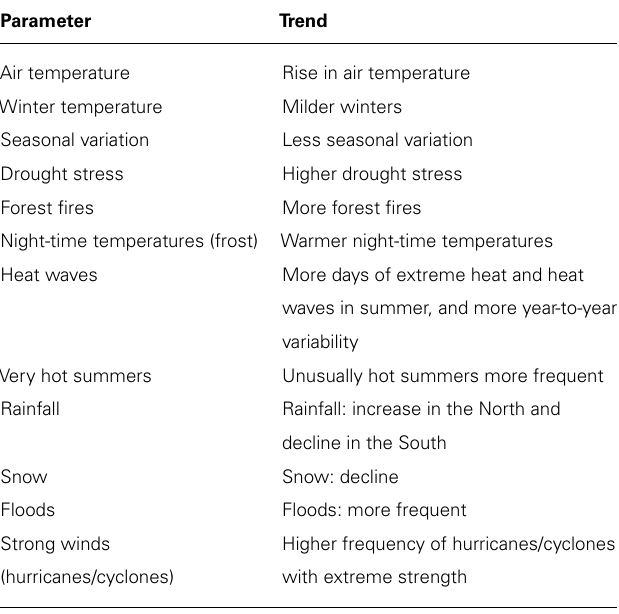
Table 2 | Long-term climatic trends in Europe, based on data from PRUDENCE* (Prediction of Regional scenarios and Uncertainties for Defining EuropeaN Climate change risks and Effects; Christensen,